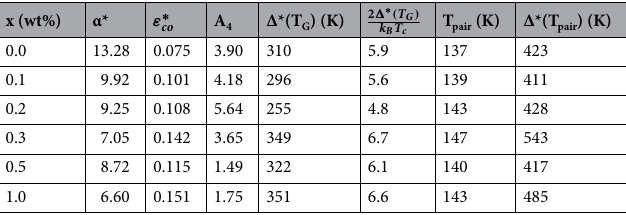
Table 2. Parameters of pseudogap analyses using local pairs